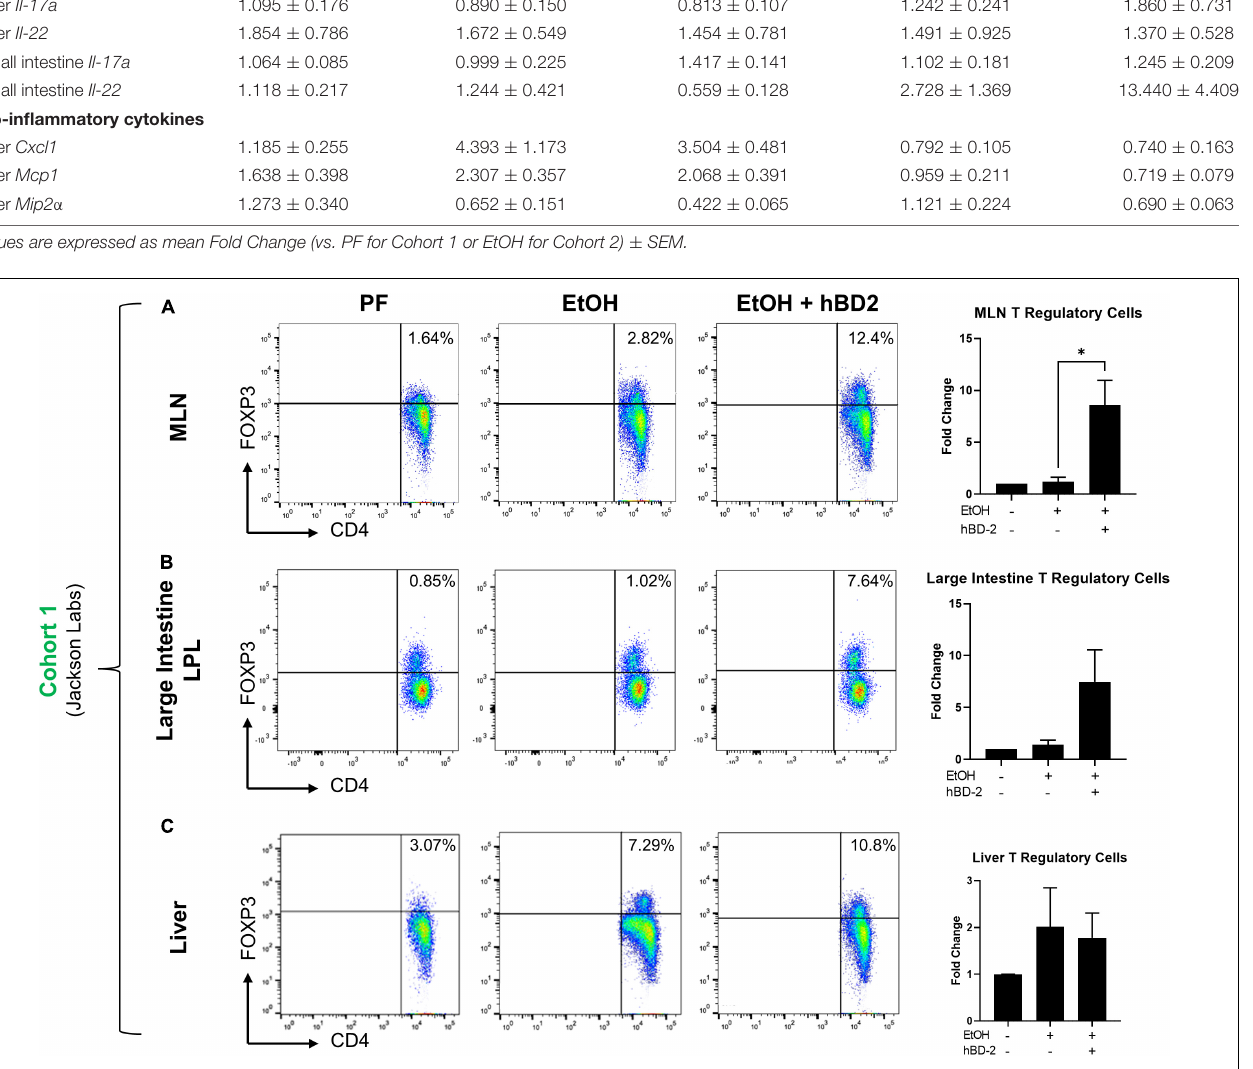
cells were altered in hBD-2 treated mice, including CD4 + IFN γ + Th1 and CD4 + IL17 + Th17 T helper cells, CD4 + FOXP3 + T regulatory cells (Tregs), and B220 + IgA + and B220 + IgM + B cells. We analyzed these cell populations in the mesenteric lymph nodes (MLN), lamina propria, intraepithelial large and small intestine compartments, and liver of Cohort 1 mice